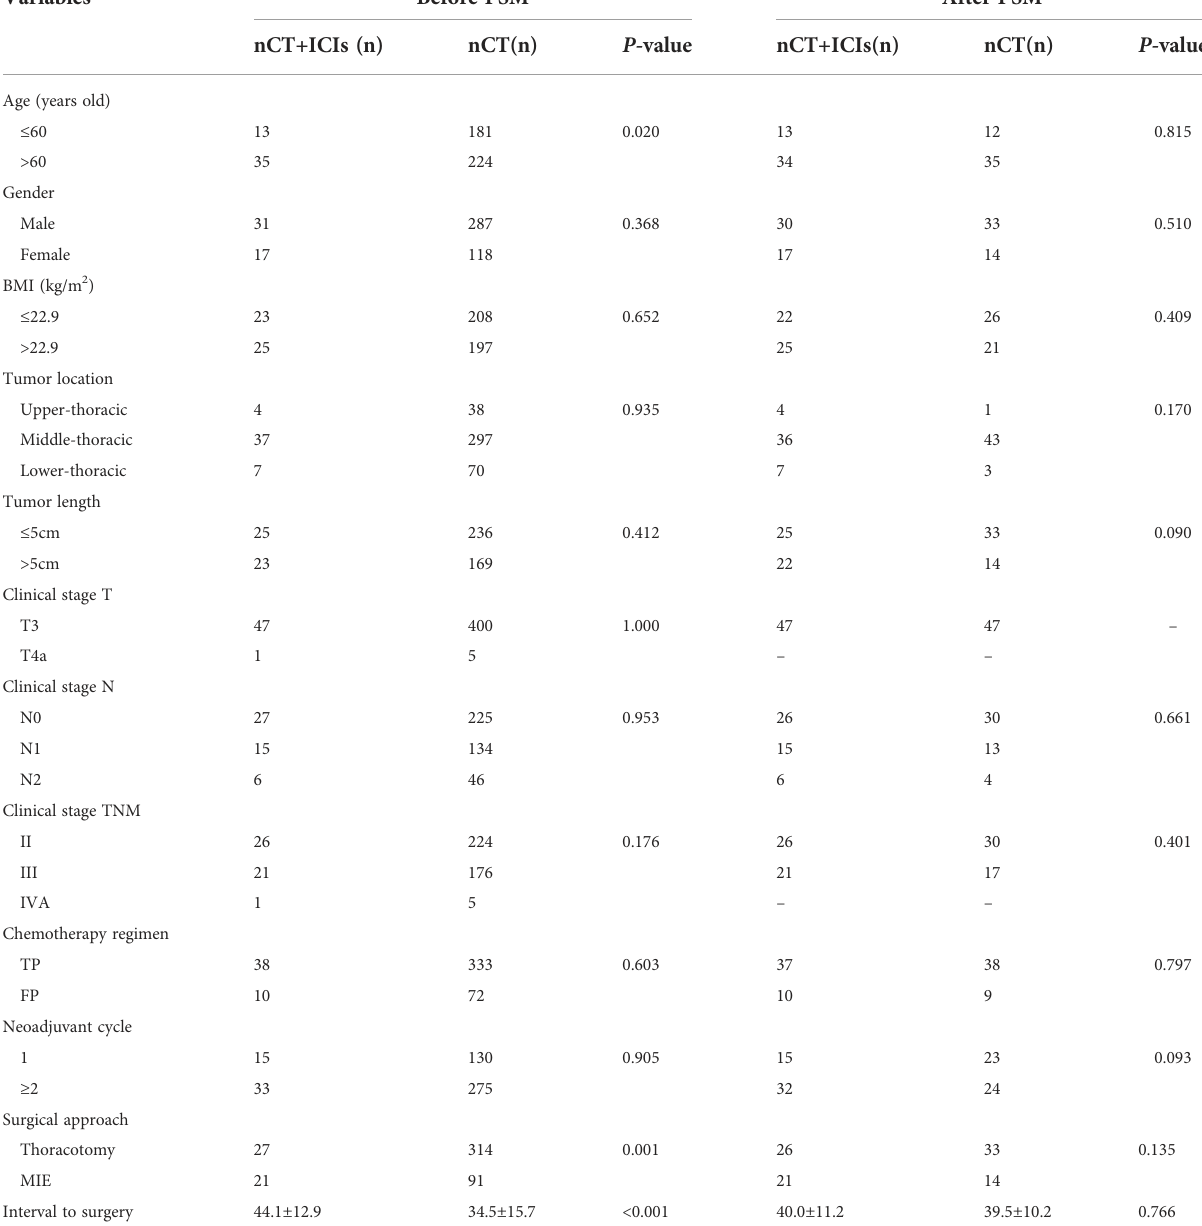
TABLE 1 Baseline characteristics before and after